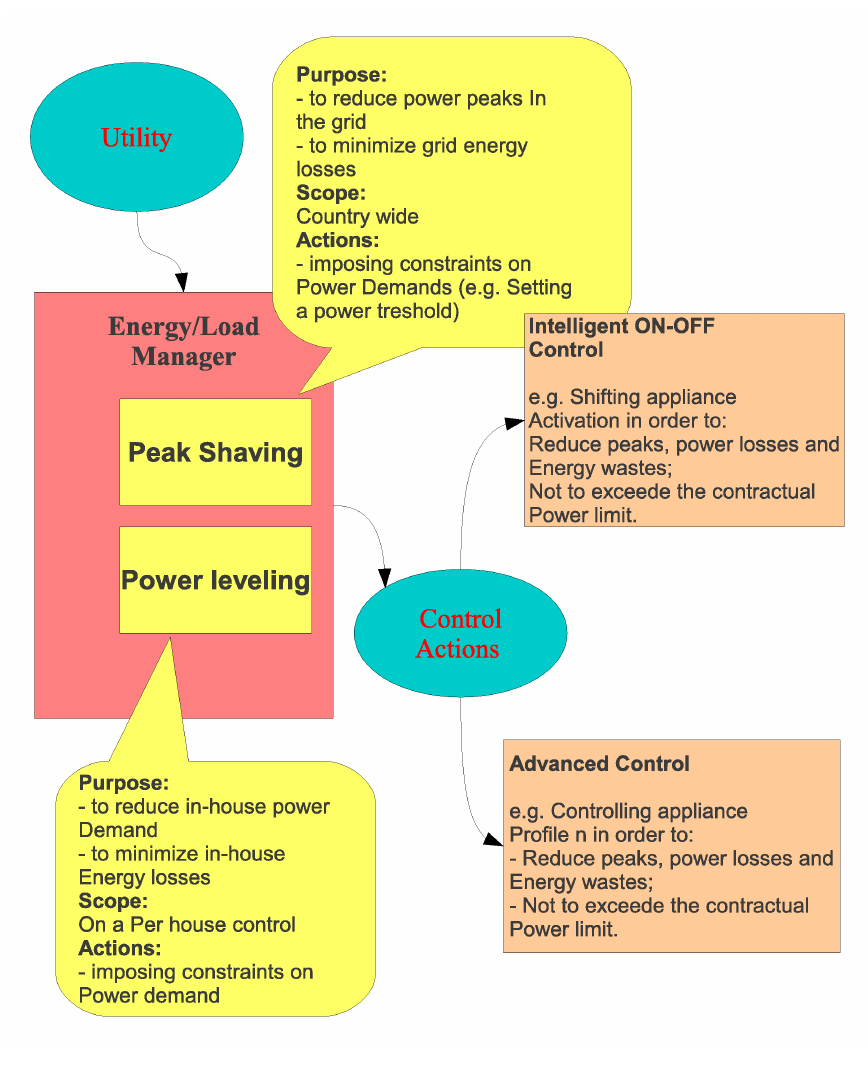
Figure 4. DSM function block diagram.